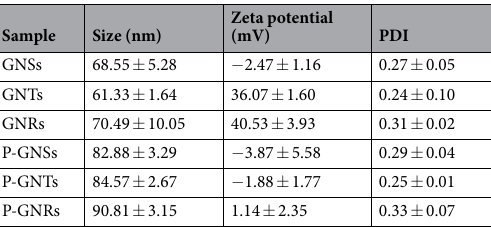
Table 1. Hydrodynamic size, zeta potential and polydispersity index (PDI) of various GNPs. Data are provided as mean ± S.D. (n =